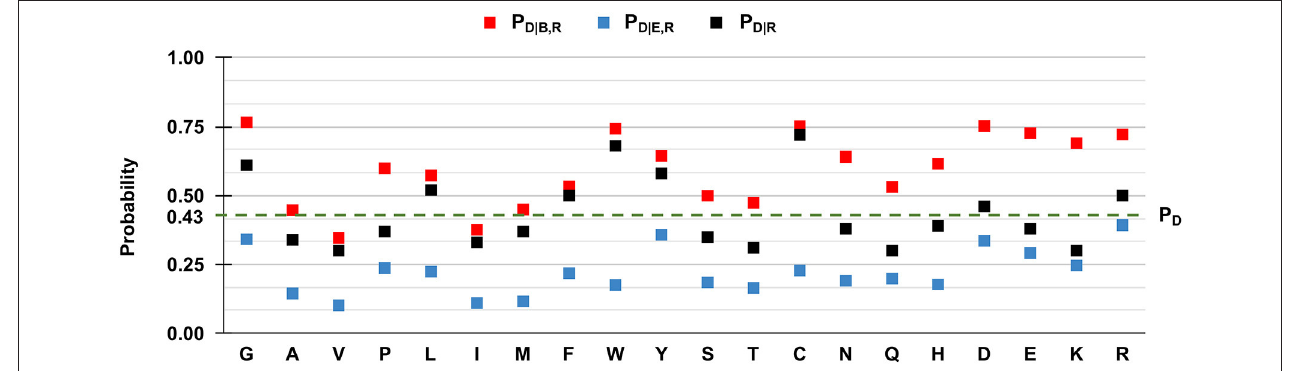
FIGURE 5 | Frequency of disease-related SRVs, depending on the wild type residue and the exposure state in HVARSEQ. Here, buried and exposure states of each residue position have been predicted using the method described in Section Analyzing distributions of variated wild-type residues in the sequence database. P D : the probability of a wild-type residue (position) to be disease associated in the HVARSEQ dataset [see Equation (1)]. P D | R : the conditional probability of being disease related when variated, given a wild-type residue [see Equation (2)]. P D | B , R : the conditional probability of a wild-type residue to be disease related upon variation when buried [see Equation (3)]. P D | E , R : the conditional probability of a wild-type residue R to be disease related upon variation when exposed [see Equation (4)].